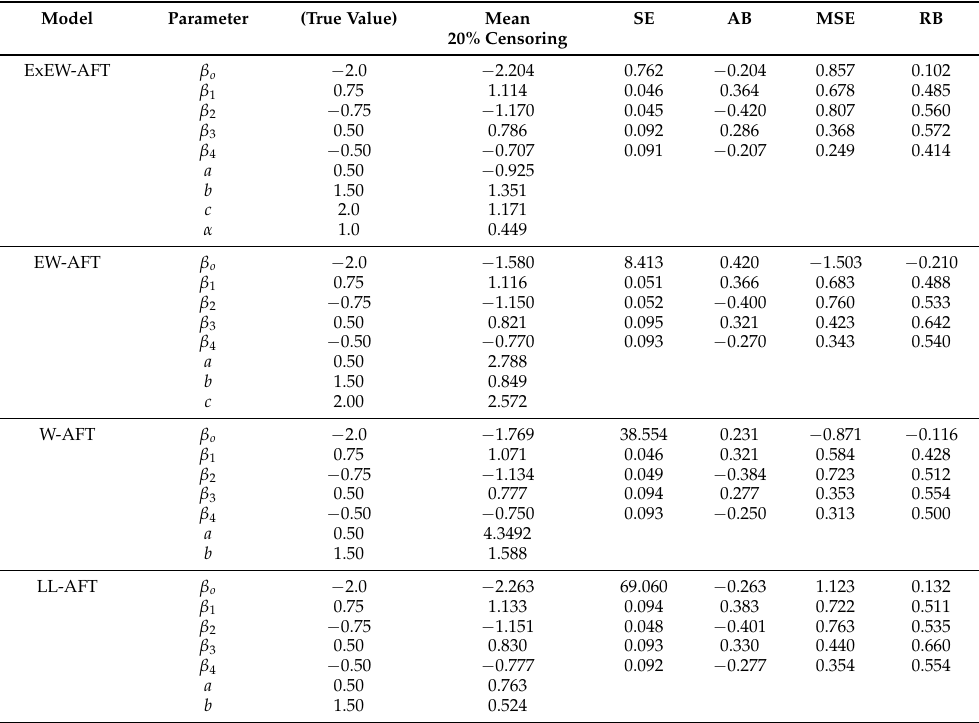
Table 9. Simulation study for scenario 3 ( n = 1000) with about 20% censored observations is used to compare model performance.